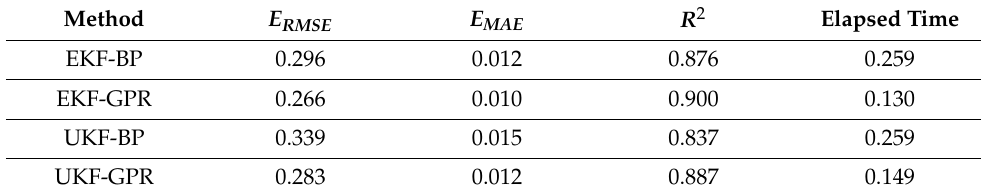
Table 2. Comparison of different algorithms based on capacity test cycles.